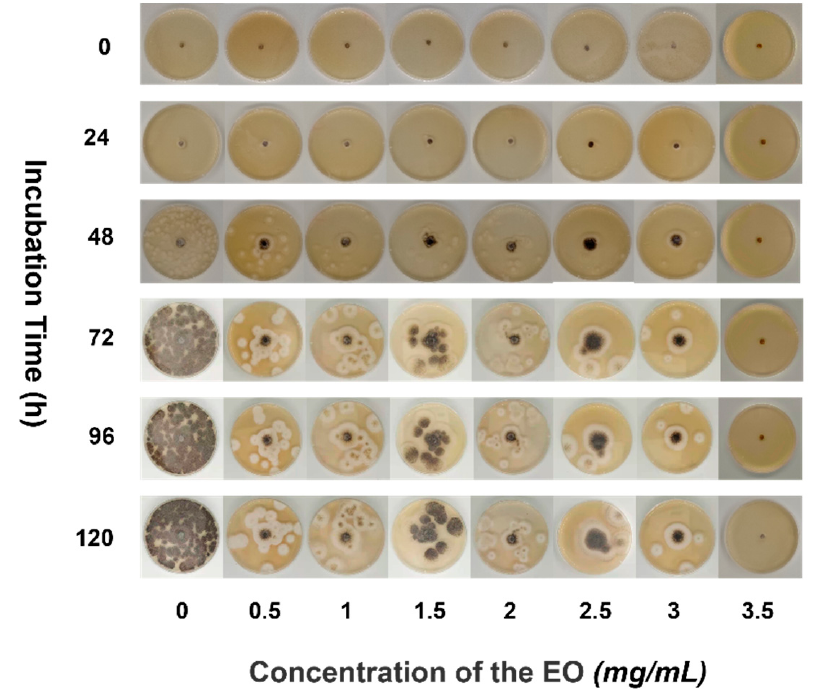
Figure 4. Antifungal process of PPEO.